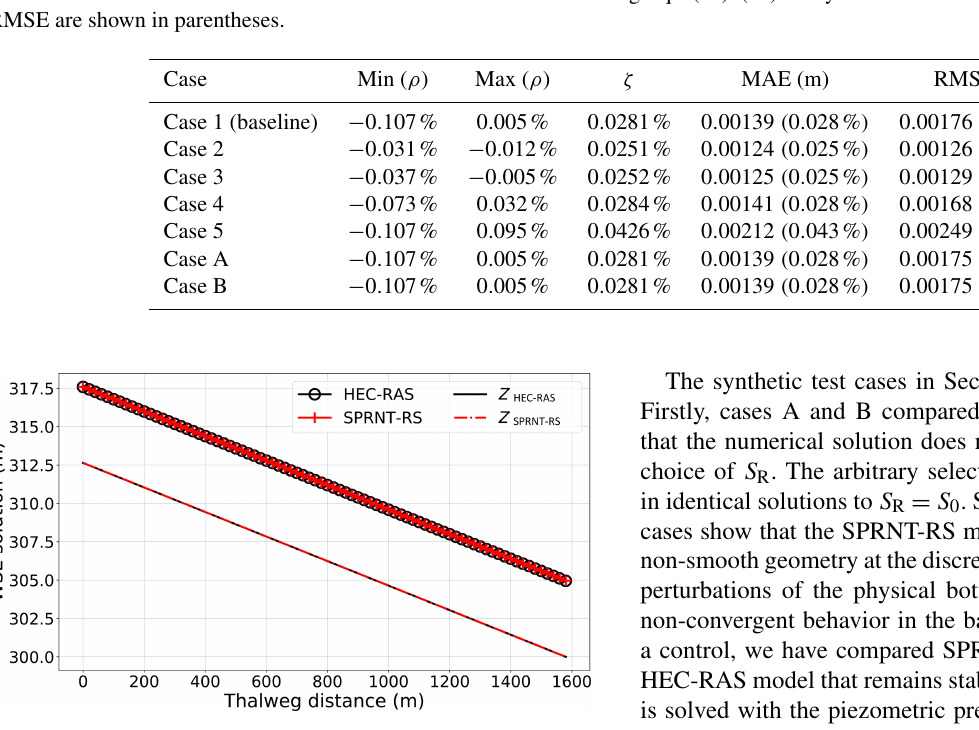
Figure 14. Simulated profile of water surface elevation (upper line) and channel bottom (lower line) for synthetic test Case 1 using SPRNT-RS (red) and unsteady HEC-RAS